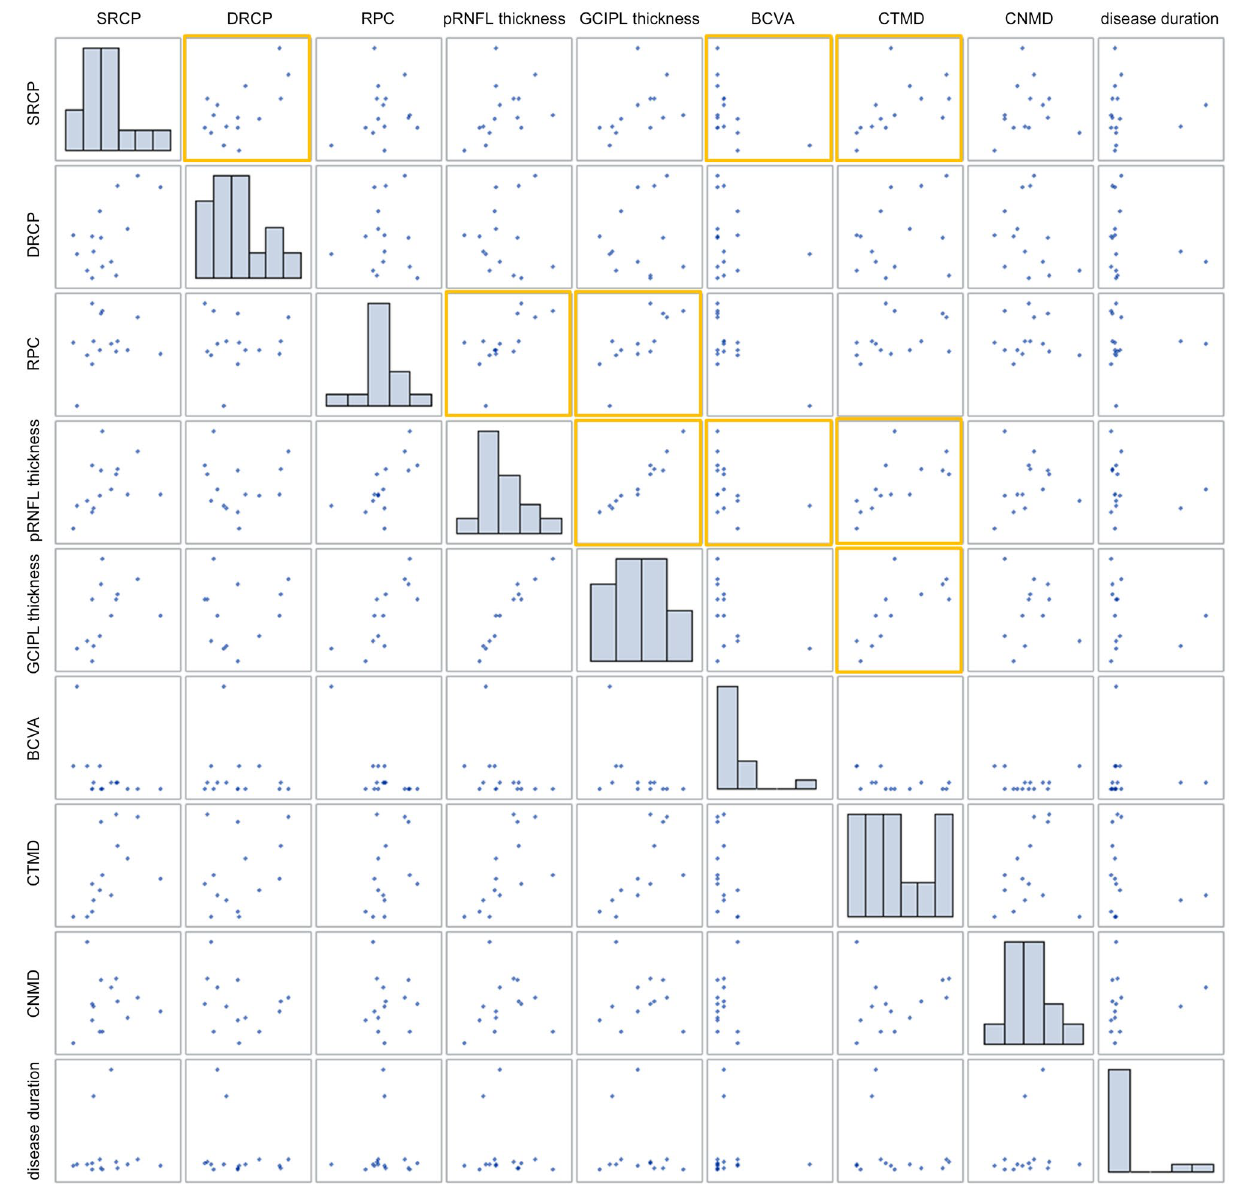
Figure 2. The scatter plot matrix shows the association between postoperative vessel densities and other parameters including the peripapillary retinal nerve fiber layer thickness (pRNFL), the ganglion cell-inner plexiform layer (GCIPL) thickness, logMAR best-corrected visual acuity (BCVA), visual field (VF) sensitivity, and disease duration. The pRNFL (r = 0.6602, p = 0.0074) and GCIPL (r = 0.7532, p = 0.0030) thicknesses showed significant correlations with the vessel densities in the RPC segment. Additionally, logMAR BCVA (r = − 0.5517, p = 0.0330) and temporal VF sensitivity loss (r = 0.5394, p = 0.0465) showed a significant correlation with SRCP vessel density. Otherwise, there was no significant correlation between vessel densities in the DRCP area and the inner retinal layer thicknesses or functional parameters, including VF sensitivity and